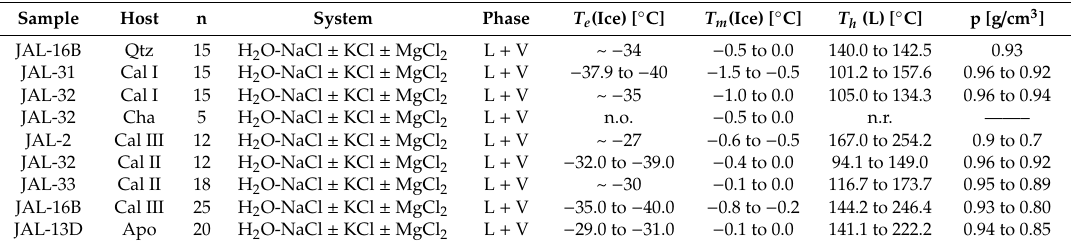
Table 5. Summary of fluid inclusions properties. T e (Ice) = temperature of eutectic melting of ice; T m (Ice) = temperature of final melting of ice; T h (L) = temperature and homogenization into liquid; n = number of fluid inclusions measured; n.o. not observed; and n.r. not reproducible.